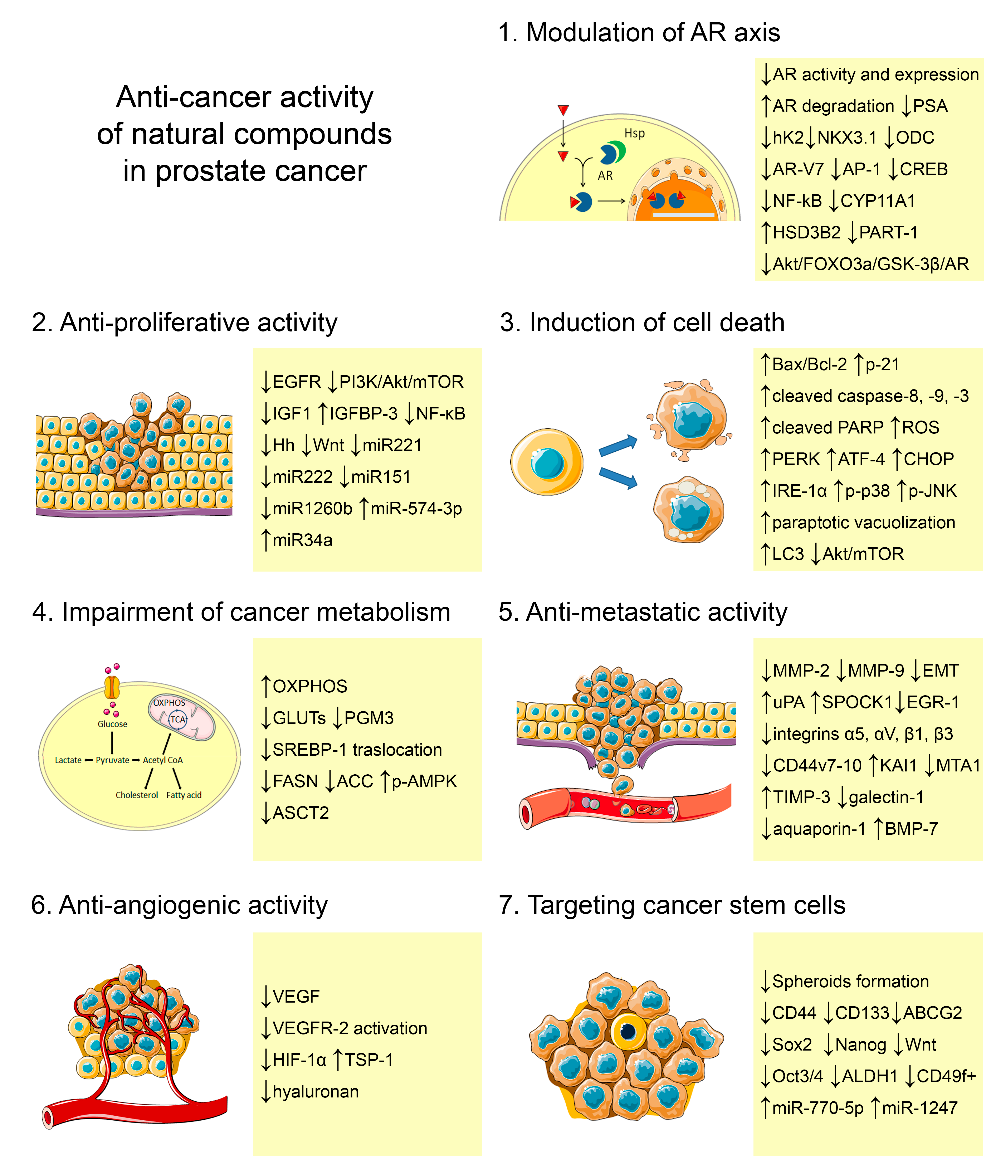
Figure 2. Mechanisms of action and molecular targets of phytochemicals in PCa. Table 1. Main signaling pathways modulated by phytochemicals in PCa.